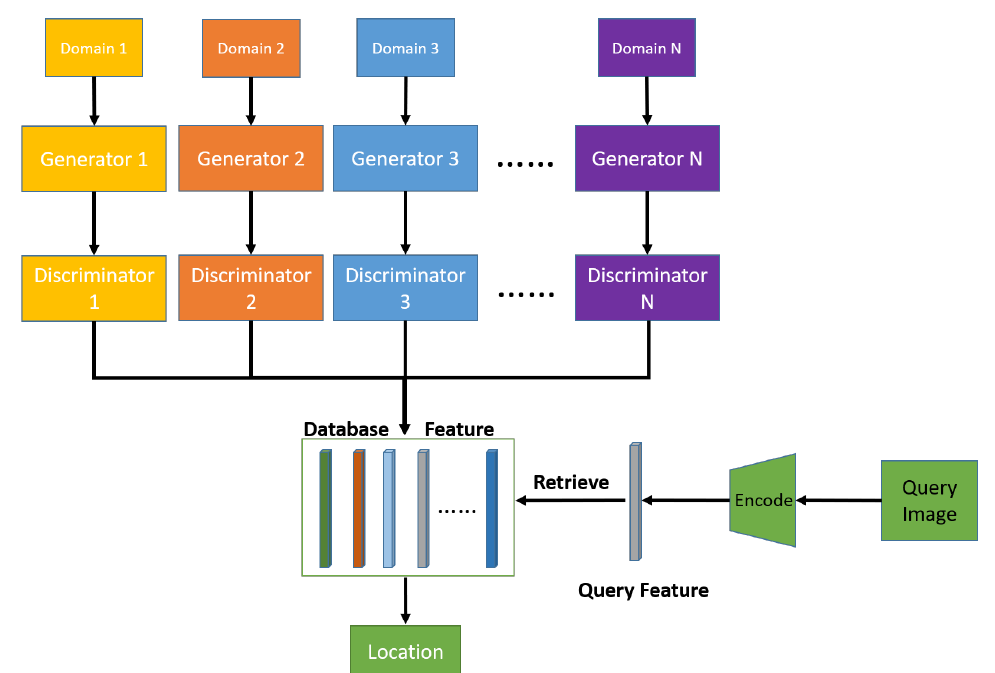
Figure 4. The overall procedures of the proposed multi-floor-localization scheme. The query image is encoded as a feature vector and, then, used to retrieve the feature and image with the largest similarity in the database.